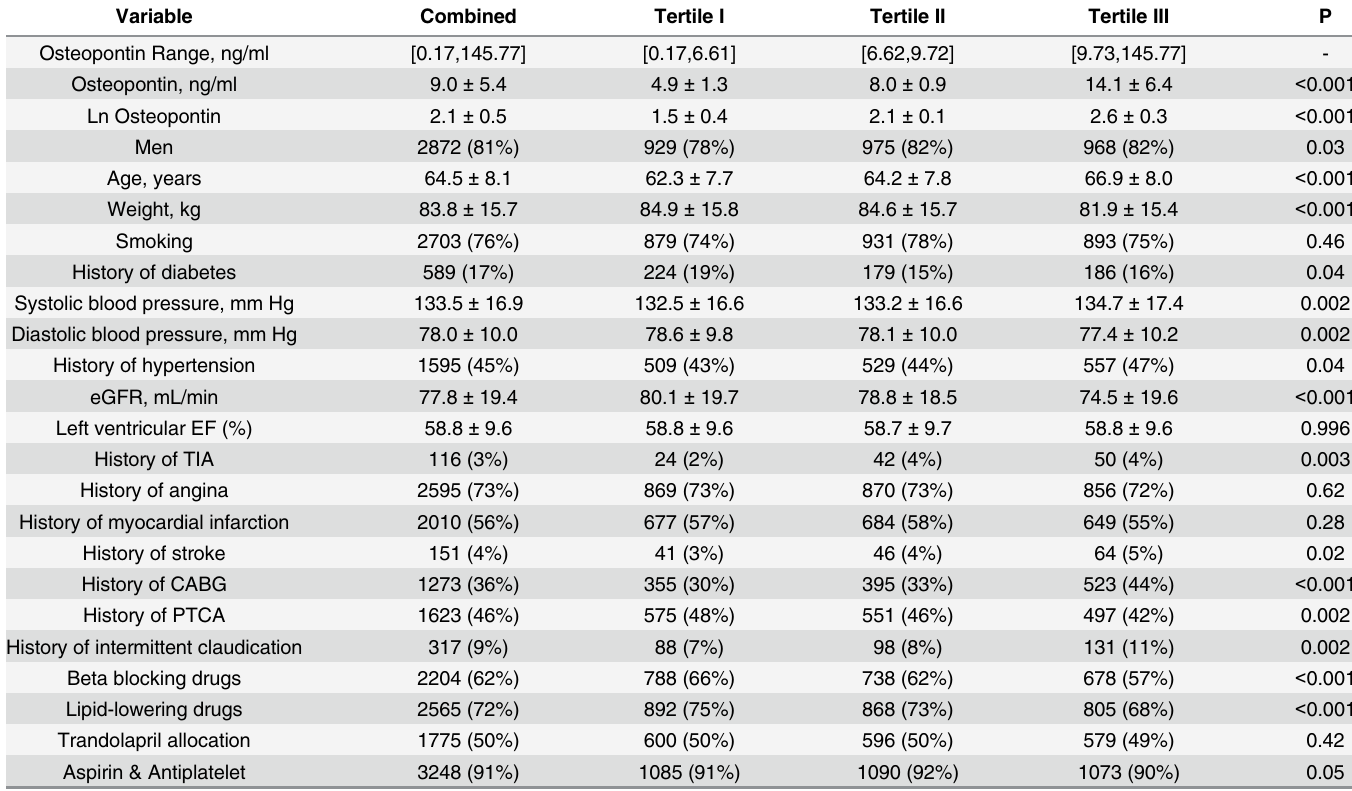
Table 1. Baseline Characteristics of the Study Patients. *